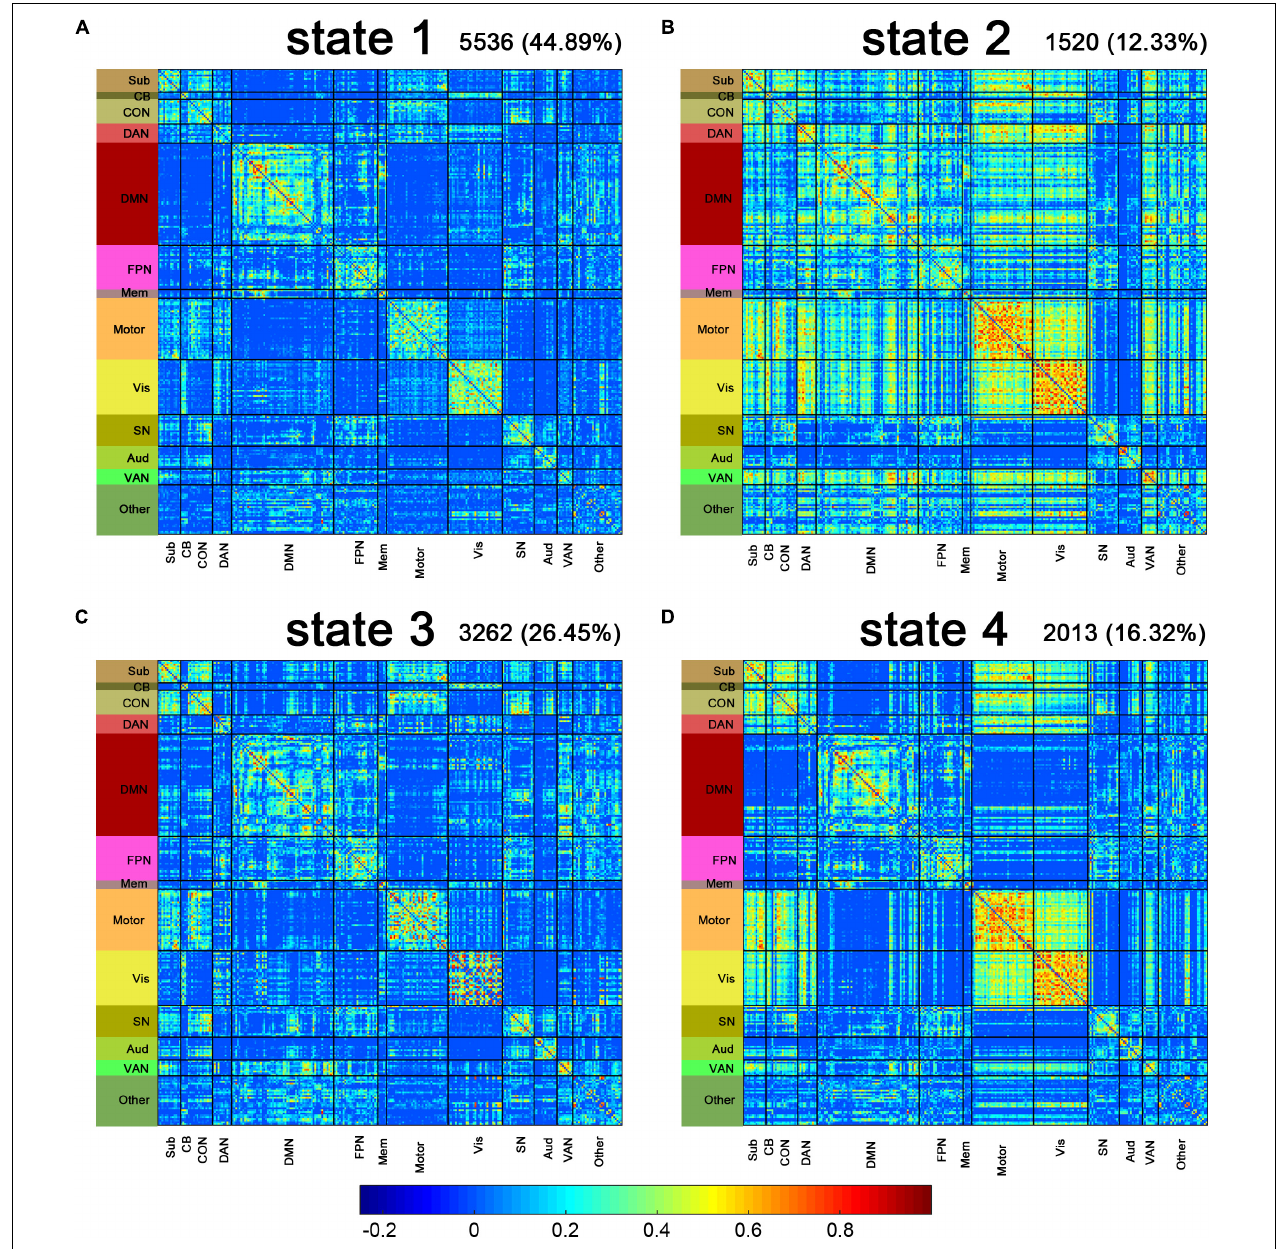
FIGURE 2 | Connectivity patterns of the dynamic functional connectivity (DFC) states. The centroids of the DFC states are shown above (A–D) . The total number and percentage of occurrences of each state are listed above each centroid. Sub, subcortical; CB, cerebellar; CON, cingulo-opercular task control; DAN, dorsal attention; DMN, default mode; FPN, fronto-parietal task control; Mem, memory retrieval; Motor, sensory/somatomotor hand; Vis, visual; SN, salience; Aud, auditory; VAN, ventral attention.